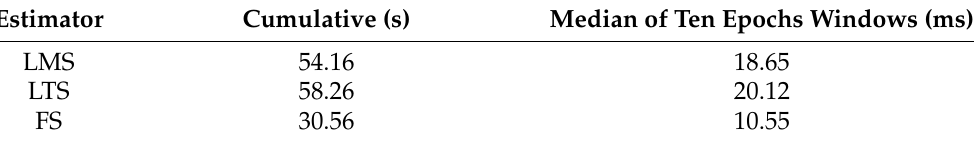
Table 2. Computing times for the three estimators. The sliding window version of the MATLAB script is applied to the same dataset and with the same MATLAB